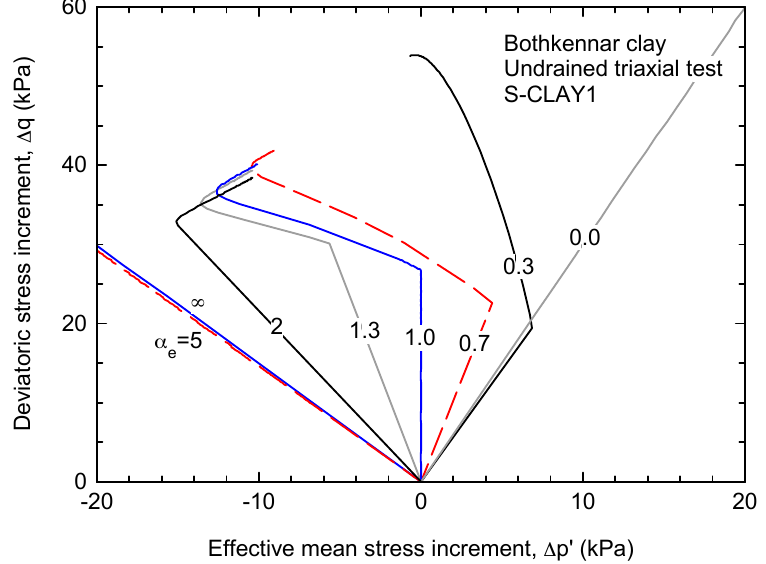
Figure 7. Effective stress path for undrained triaxial compression (each line corresponds to the anisotropic elastic parameter, (cid:2009) (cid:3032) , that is indicated over the line).